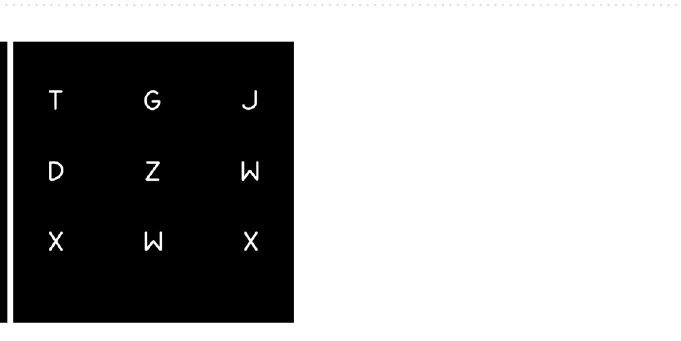
Figure 1. Examples of THz images from one-side-standard paper ( a ), one-side-Xuan paper ( b ), two-side- standard paper ( c ) and two-side-Xuan paper ( d ).